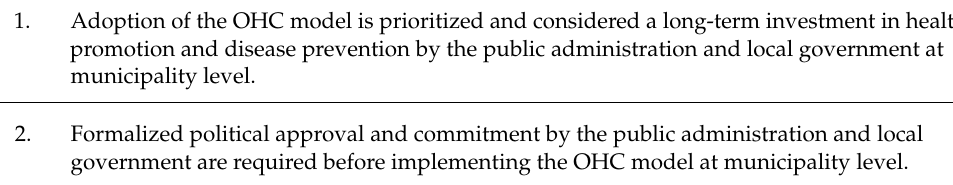
Table 1. Key assumptions for successful implementation of the OHC